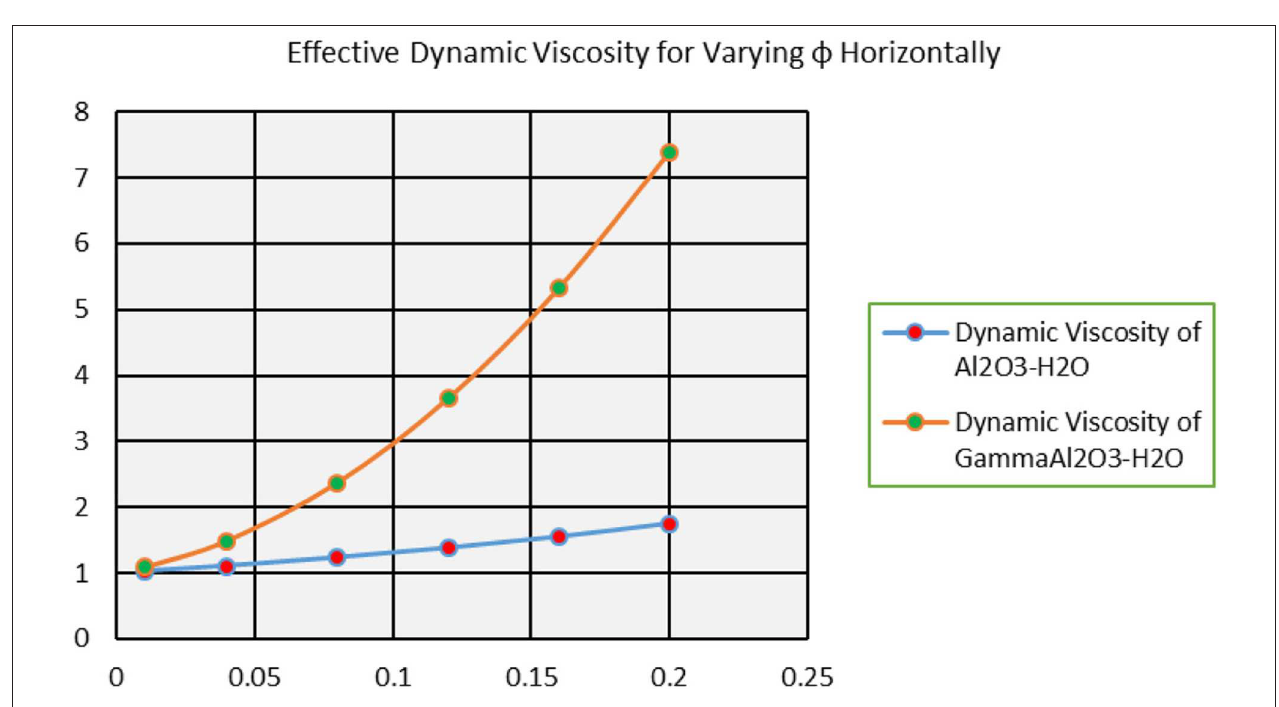
FIGURE 16 | The effects of φ on Effective Dynamic viscosity.